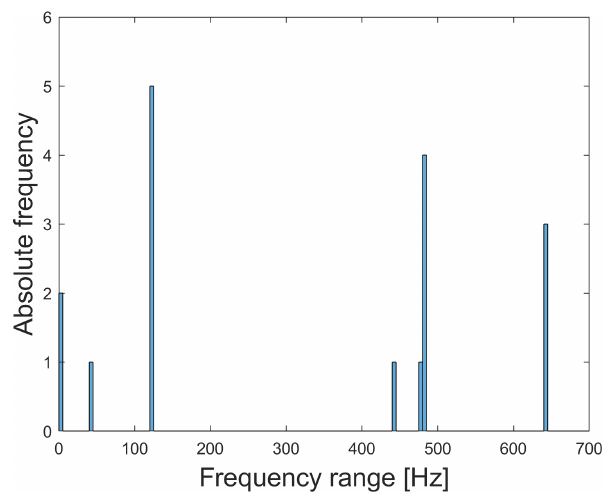
Figure 8. Frequency range of the 17 most relevant features. The frequencies of all relevant features are ≤ 640Hz.